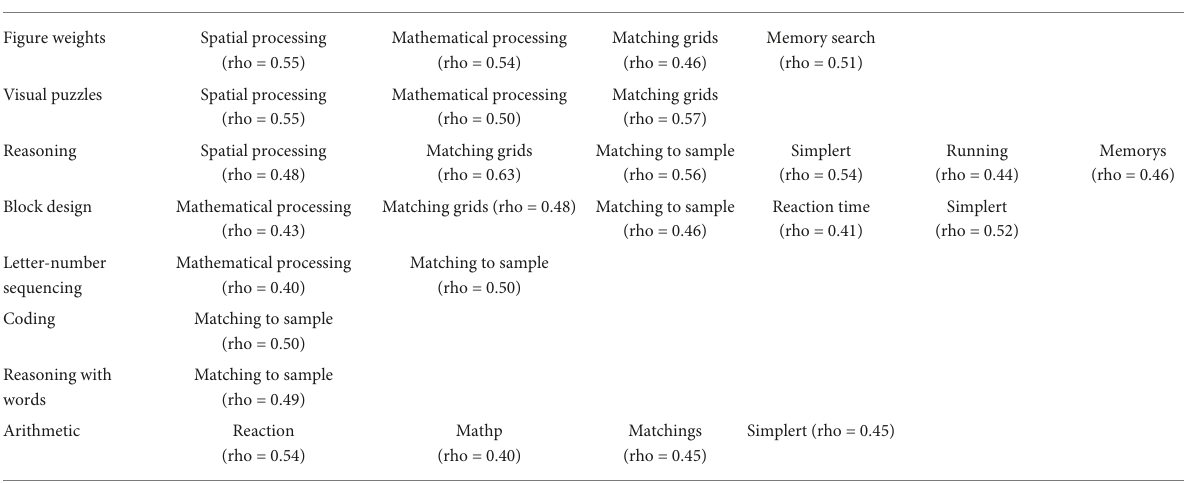
TABLE 10 Correlation between WISC and Ped-ANAM for children under 16 years old ( n = 17).